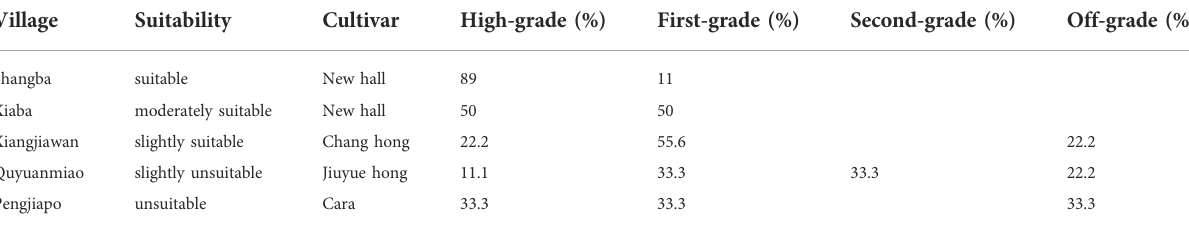
TABLE 1 Correlations of environmental suitability with citrus quality in Zigui